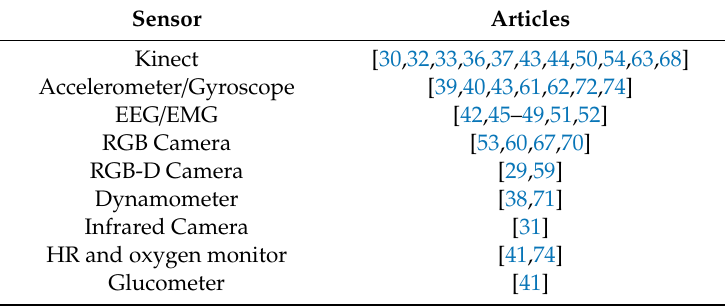
Table 4. Sensor types in articles